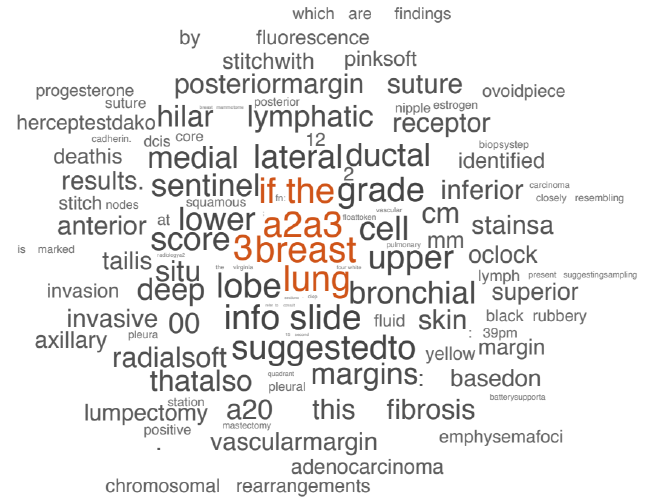
Figure 16. Word cloud map [63]. Larger tokens in the word cloud chart are ranked higher by the selection algorithm.